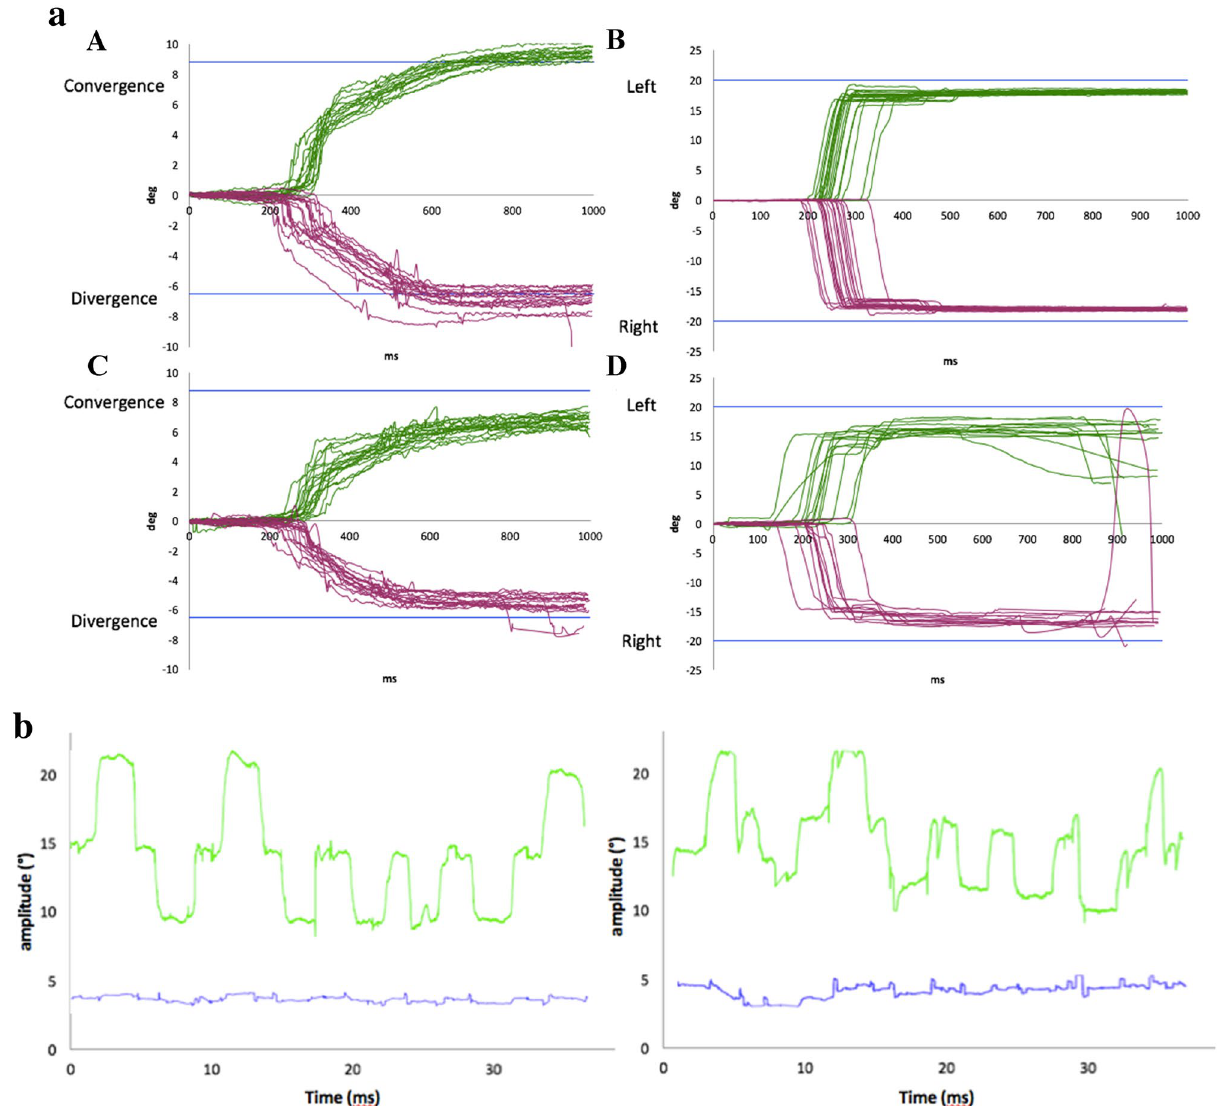
Figure 1. ( a ) Example of individual vergence and saccade trials. Tracings of vergence and saccades in an individual healthy control ( A , B ) and dyslexic ( C , D ) subject in one trial period. Despite initiating vergence movements quickly towards the target (in blue), the dyslexic subject takes longer to reach the vergence target (indeed, longer than measured). Similar difficulties can be seen in the saccade trial ( B , D ). ( b ) Example of vergence and conjugate tracing. Tracings of non-dyslexic (left) and dyslexic (right) vergence (green) movements over time. Convergence is represented by upward movements, divergence downward. The blue traces indicate conjugate saccade intrusions. Saccade intrusions are present for both, though are perhaps slightly more distinct for the dyslexic child; however, these measurements need finer analysis, perhaps with higher resolution eye trackers to better quantify eventual differences between the healthy control and the